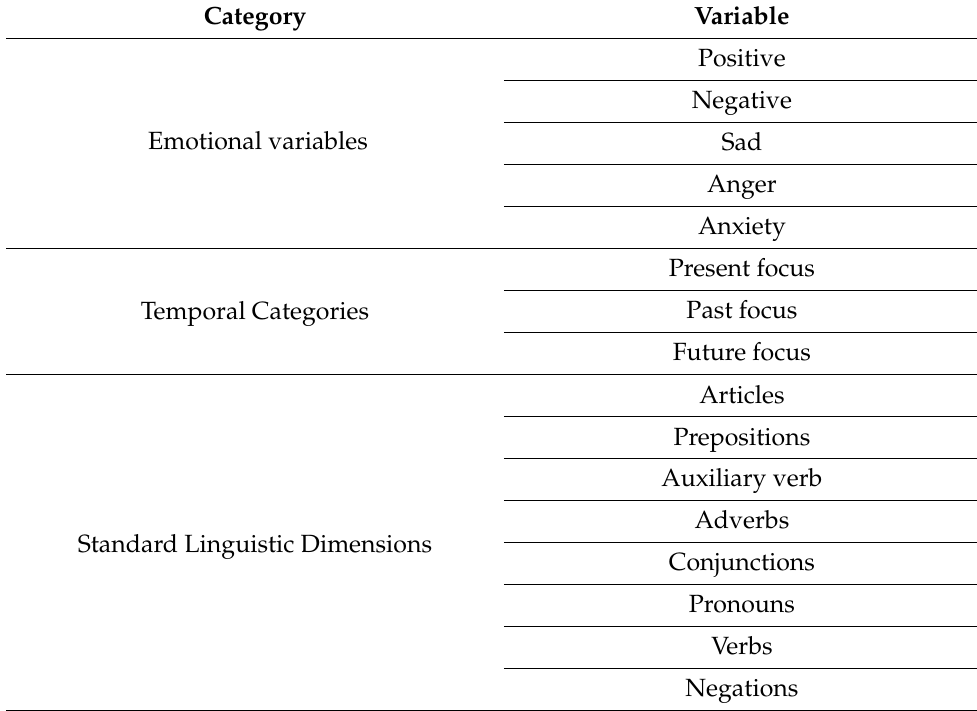
Table 2. Features used for the model that classifies comments as depressive indicative or not [18].